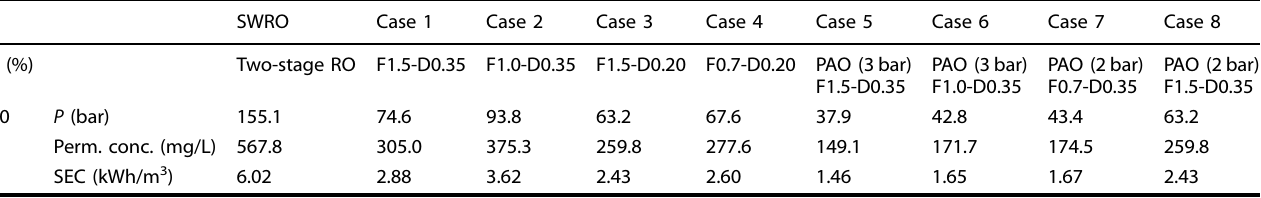
Table 2. Operating pressure and permeate quality of SWRO for the different cases (selected based on the performance test results, with a total of eight cases: four in FO mode and four in PAO mode, using the two-stage RO as the control), with a total plant recovery rate of 80%.